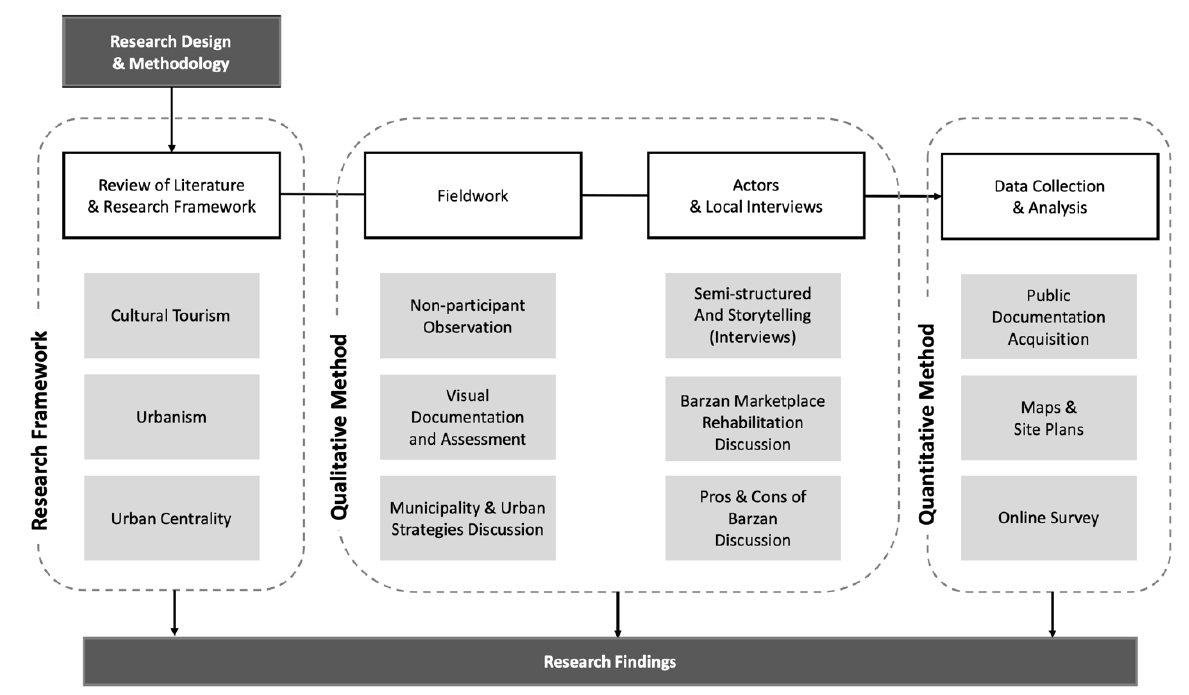
Figure 1. The research design and mixed method chart. Source: Authors.